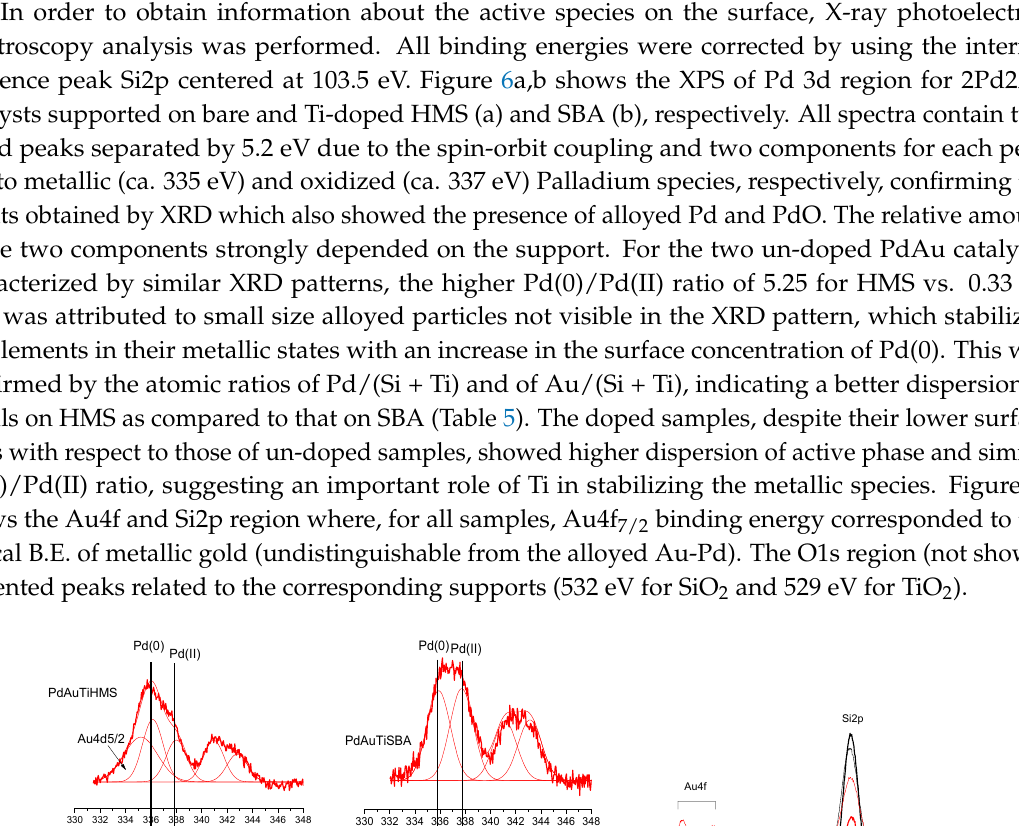
Figure 5. Wide angle XRD of Pd-Au supported on SBA ( a ) and HMS ( b ) as is or Ti-doped.